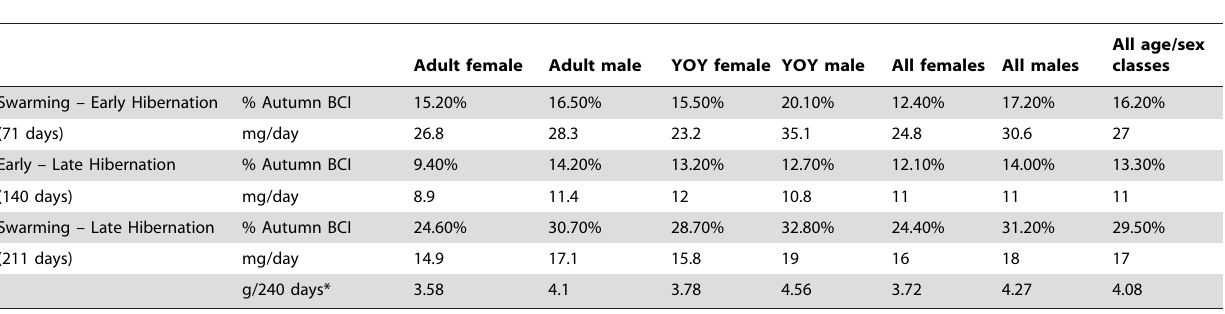
Table 1. Average percent decline in little brown bat body condition index (BCI; mass/forearm length) and rate of mass loss between swarming (15–19 Sept 2009), early hibernation (28, 29 Nov 2009) and late hibernation (27, 28 April 2010).